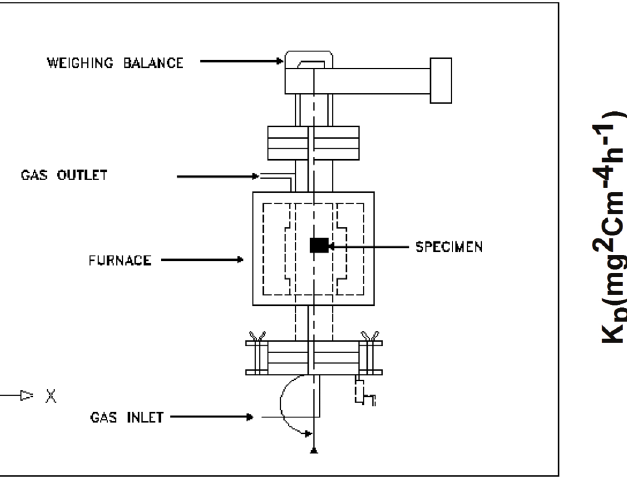
Fig. 4: Parabolic rate constant (K p ) of different percentage cold deformed samples in SO 2 +O 2 atmosphere at 923 K for 24